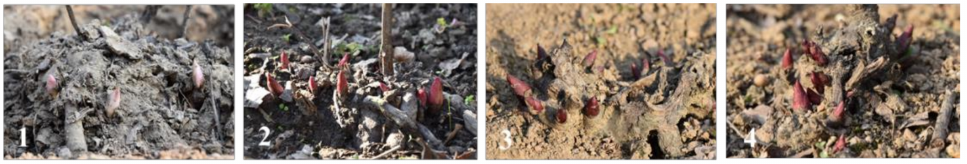
Figure 1. Growth of ‘Meiju’ buds at different stages. ‘Meiju’ was planted outside at the Perennial ( 1 ): 10 November; ( 2 ): 15 December; ( 3 ): 11 January; ( 4 ): 6 February.